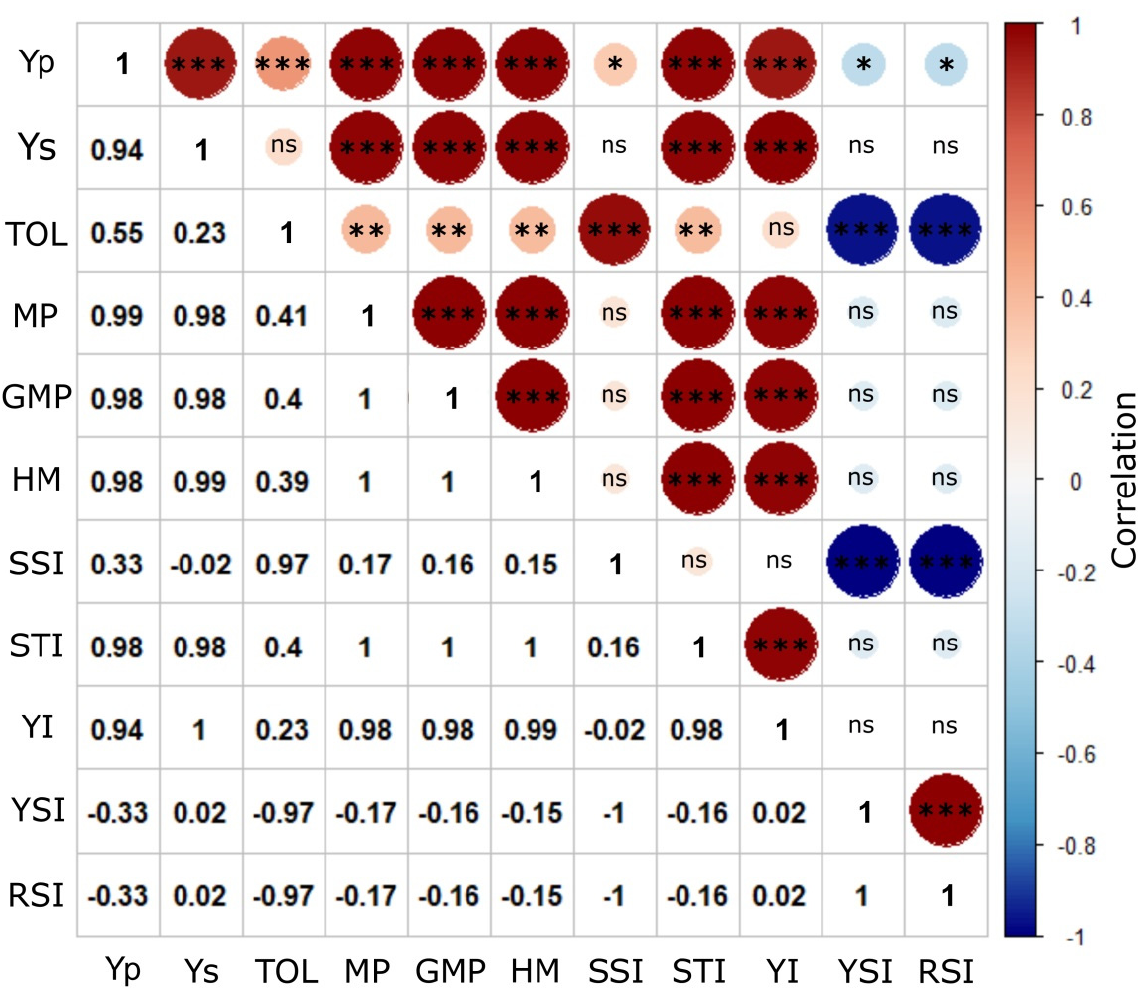
Figure 1. Correlation coefficients (r) and correlogram for the grain yield and stress screening indices. Ns—not significant, *, ** and ***—significant at the level of probability p < 0.05, 0.01 and 0.001, respectively.